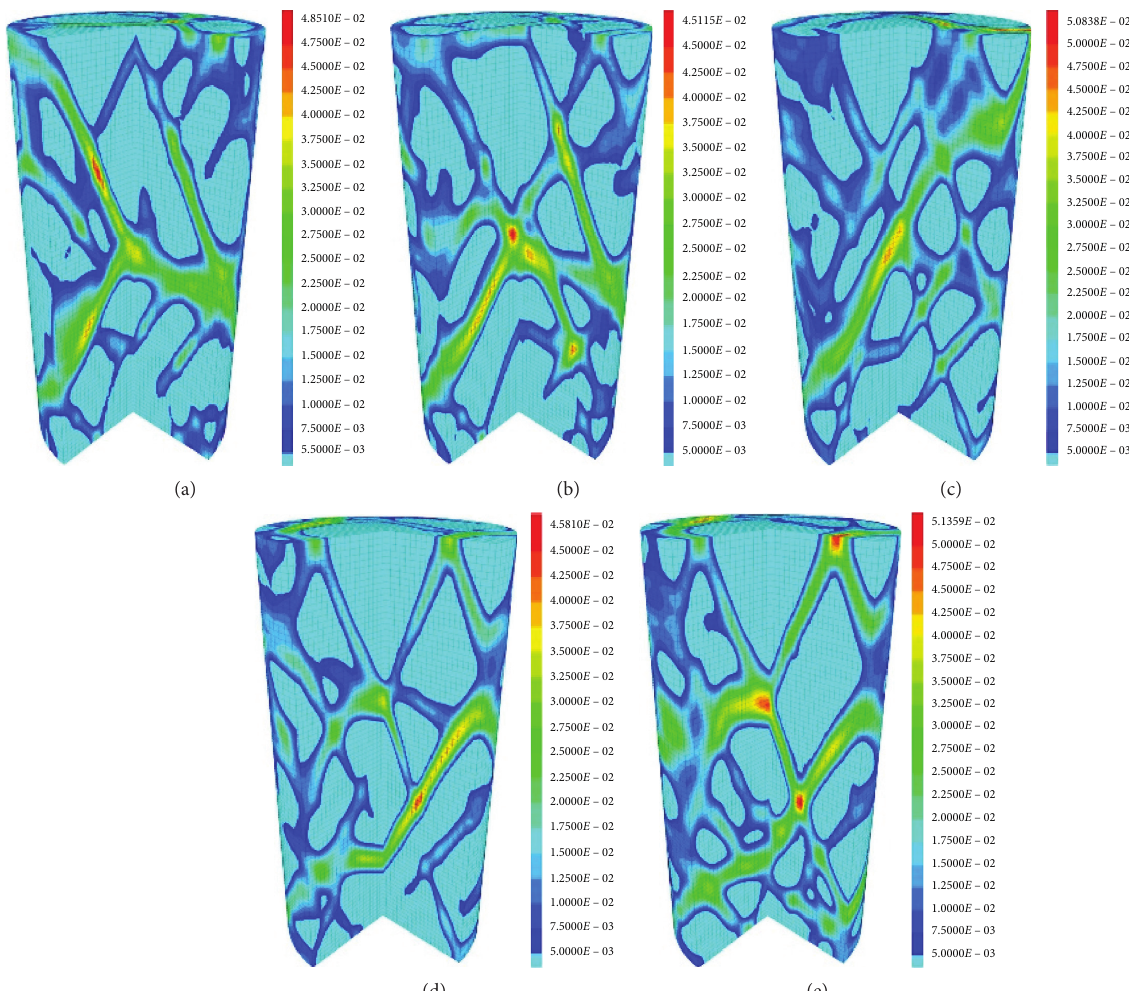
Figure 16: Volumetric strain ( ε v > 0.5%) after degradation under varied confining pressure. (a) σ 3 � 5 MPa. (b) σ 3 � 10 MPa. (c) σ 3 � 15 MPa. (d) σ 3 � 20 MPa. (e) σ 3 � 30